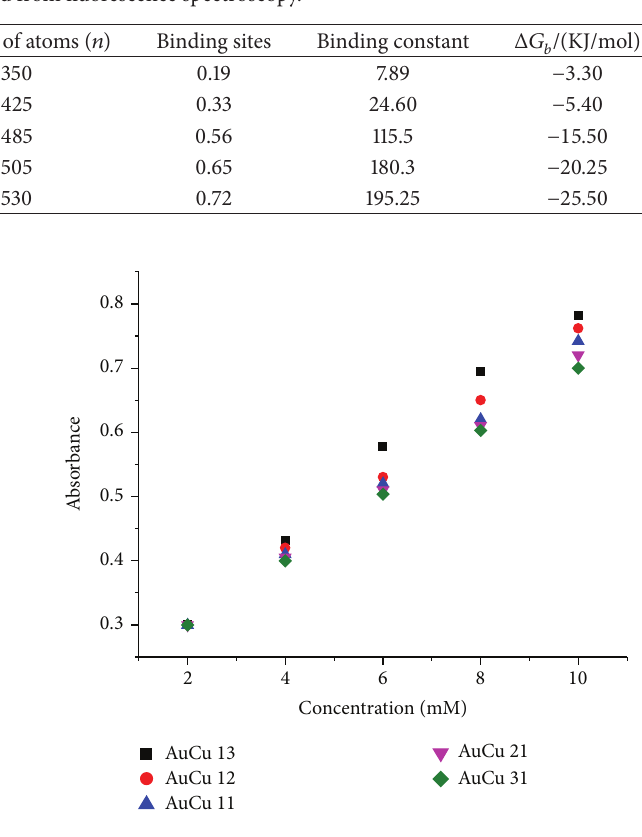
Figure 4: Plots of absorbance versus concentration for Au-Cu. and hypochromic effect in the intensity from Au-Cu 3 : 1 to Au-Cu 1 : 1, but that from Au-Cu 1 : 1 to Au-Cu 1 : 3